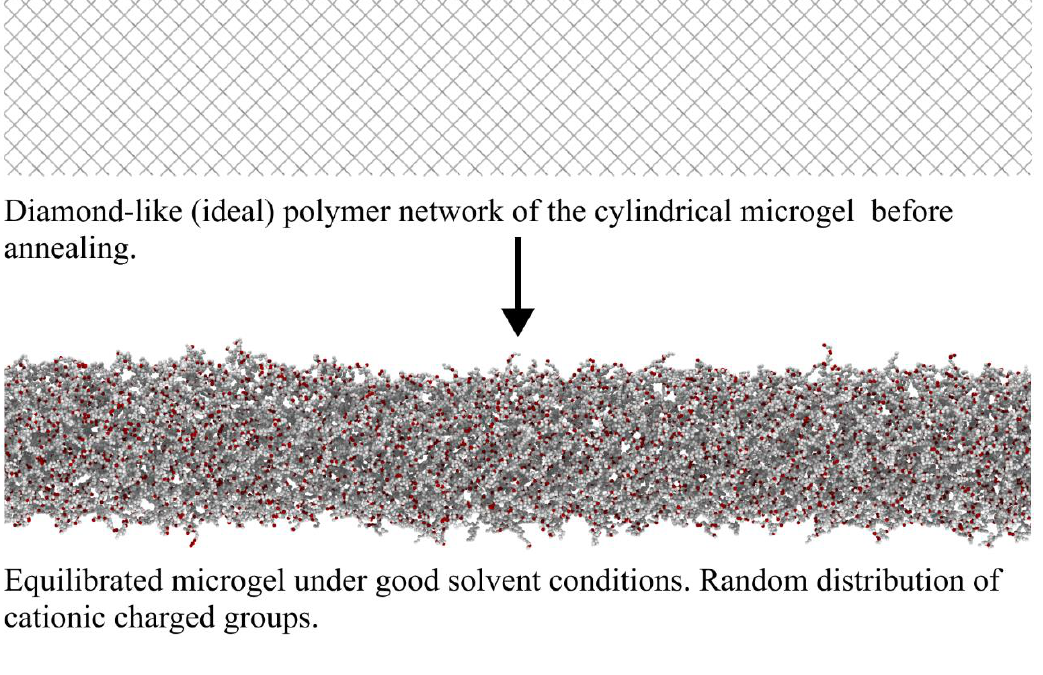
Figure 1. Internal structure (thin layer near the axis) of the cylindrical microgel before and after annealing. The charged groups (red beads) are randomly distributed over the network. Interactions between network beads are quantified by the interaction parameter ε .